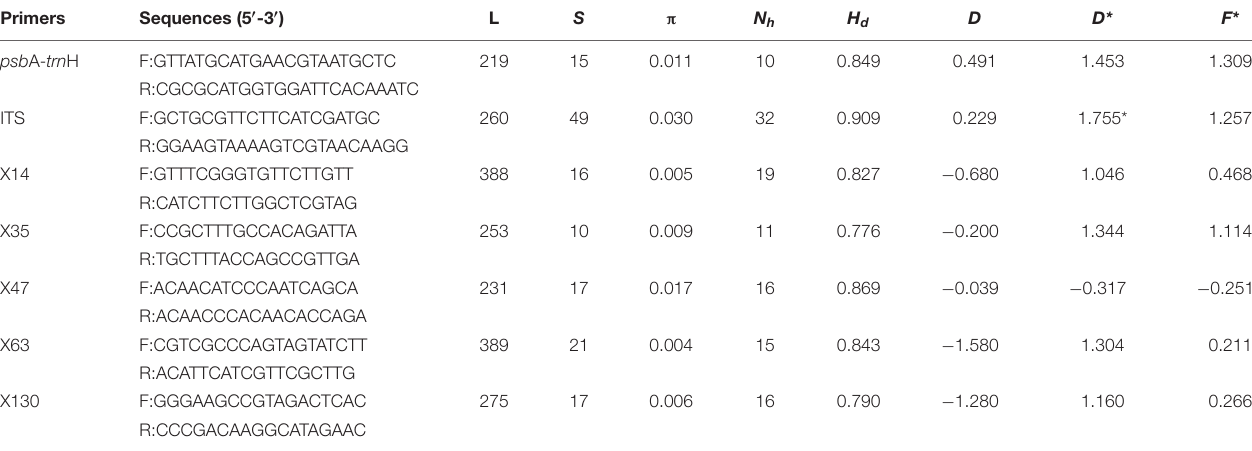
TABLE 3 | The genetic diversity and neutrality tests of six nuclear loci and one chloroplast fragment used in this study.